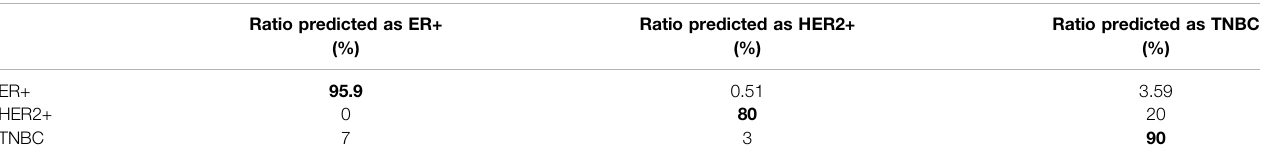
Ratio predicted as ER+ (%)